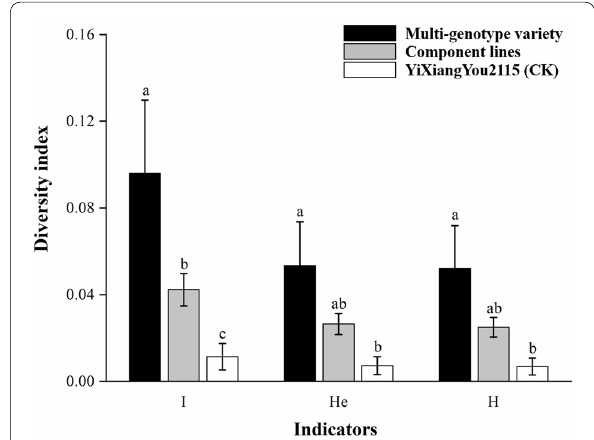
Fig. 2 Genetic diversity of multi‑genotype varieties and their component lines detected by SSR makers. I, Shannon index; He, expected heterozygosity; H, Nei’s diversity index. Bars represent standard error and different letters above bars indicate significant differences at P < 0.05 based on Duncan’s test (n